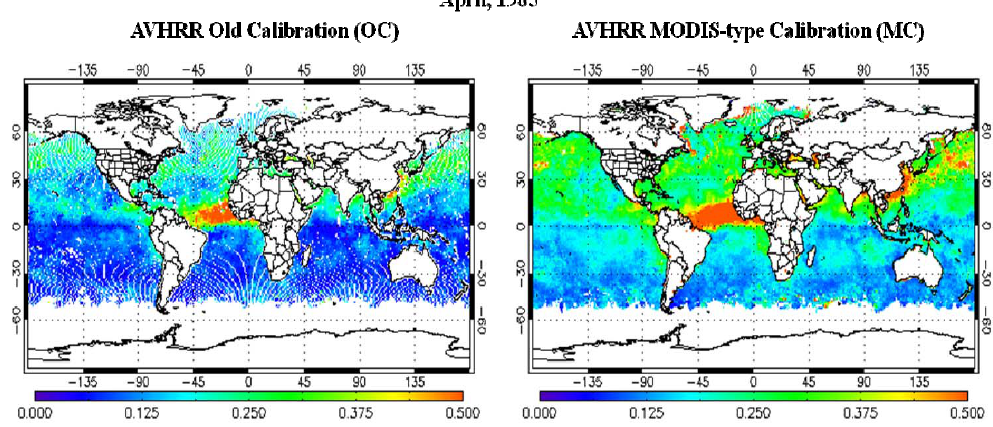
Fig. 2. Monthly mean maps of AOD at 0.63 µ m for April 1985 derived from old AVHRR radiances (left panel) and retrospectively calibrated Figure 2. Monthly mean maps of AOD at 0.63  m for April 1985 derived from old AVHRR AVHRR radiances using MODIS radiances (right panel). radiances (left panel) and retrospectively calibrated AVHRR radiances using MODIS radiances (right panel).